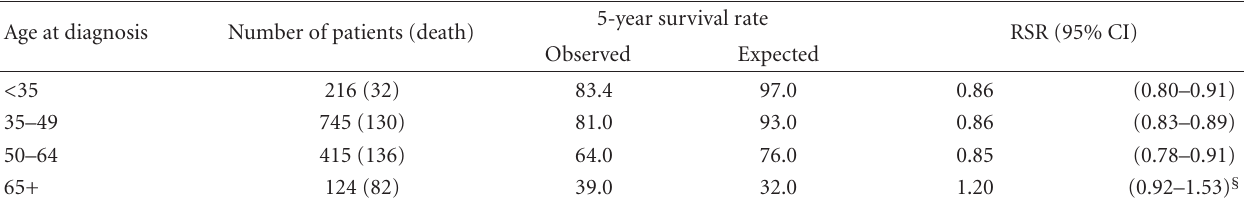
Table 3: Observed, expected, and relative survival rate (RSR) of breast cancer patients in Iran, diagnosed in